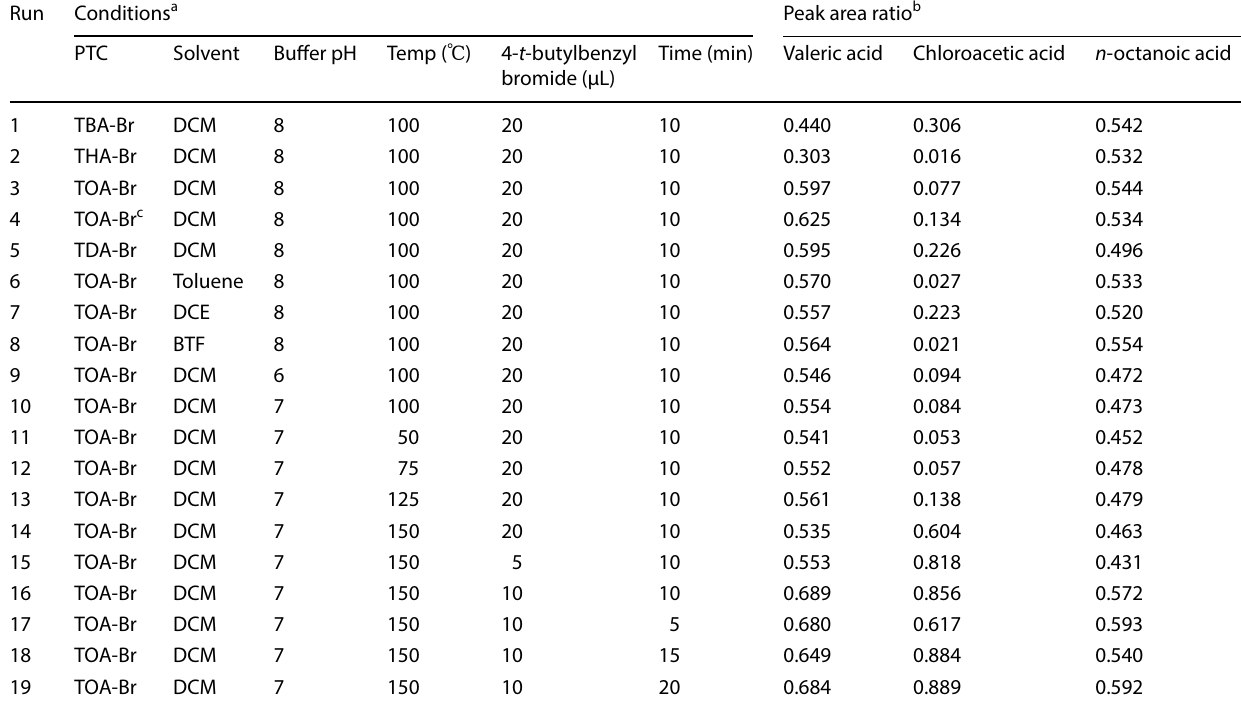
Table 2 Derivatization